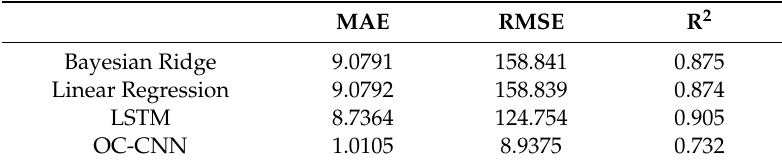
Table 1. The MAEs, MREs, and R 2 of di ff erent models.